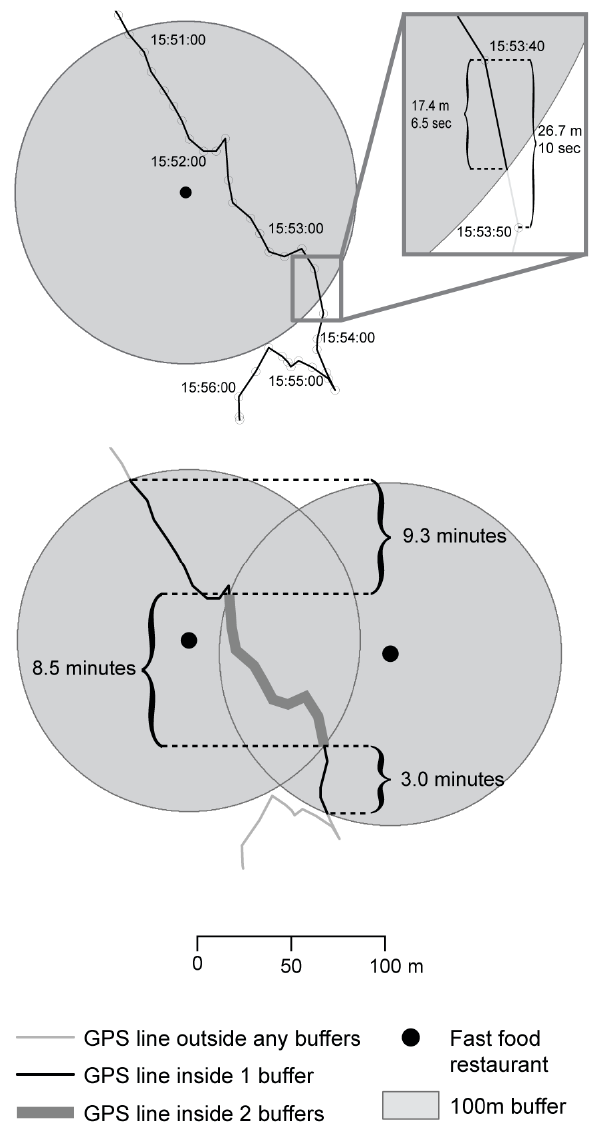
Figure 1. Estimation of time spent in proximity to fast food restaurants (FFRs).